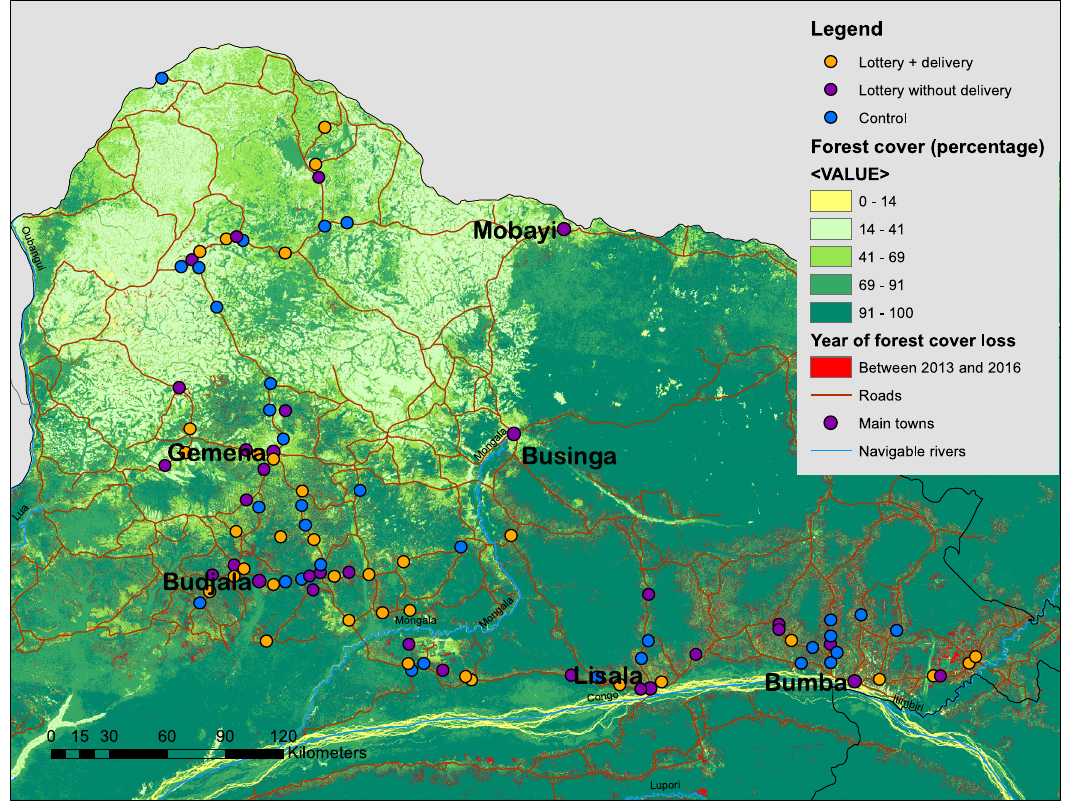
Fig. 2 | Localization of villages, forest cover, and forest cover loss in the PARRSA project area. Note: Map of PARRSA project area. Hansen forest cover is the percentage of the grid cell covered with forest according to the Hansen dataset. Localization of n =92 independent villages shown on the map.